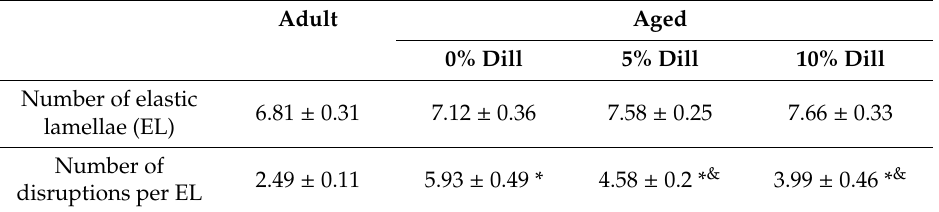
Table 2. Histomorphometric analysis of the elastic lamellae in the ascending aorta